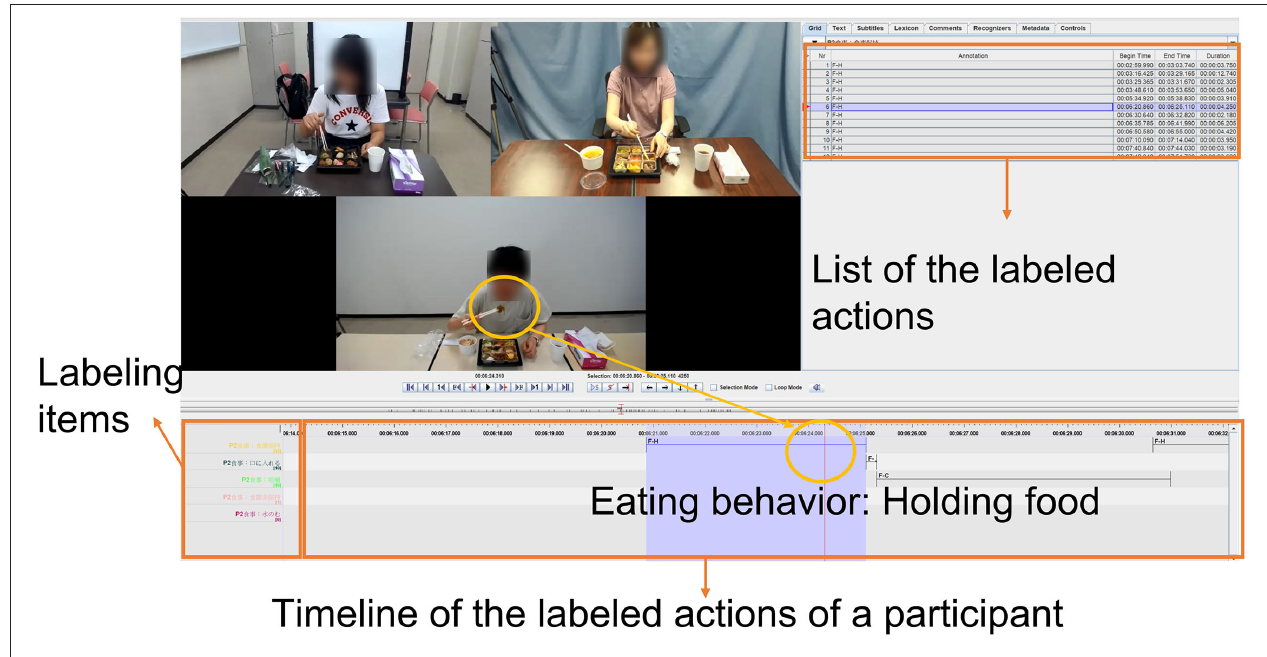
FIGURE 1 | Image of video analysis using ELAN.